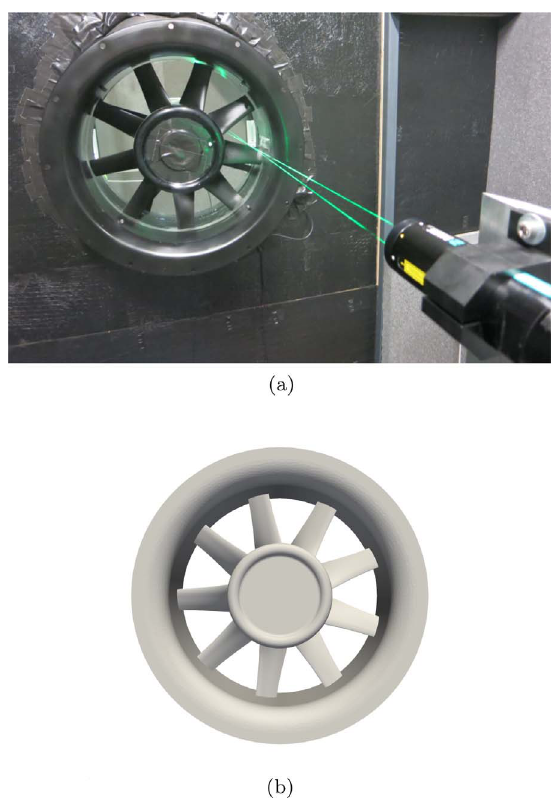
Figure 4. Fan geometry of the measurement and simulation. (a) Fan installed in the duct measurement [12]. (b) Fan geometry of the CFD simulation.